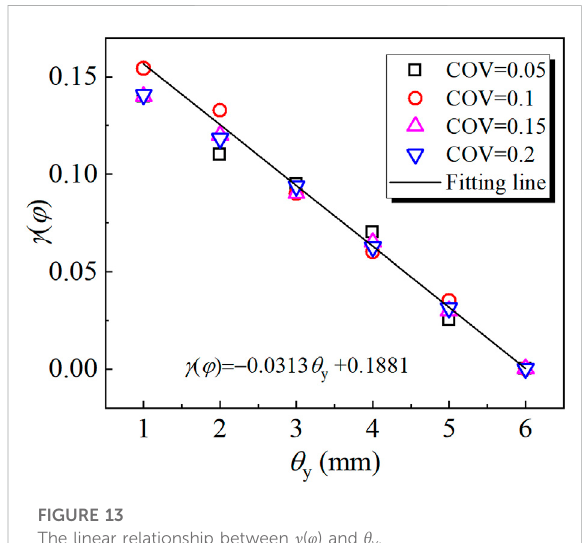
FIGURE 13 The linear relationship between γ ( φ ) and θ y .